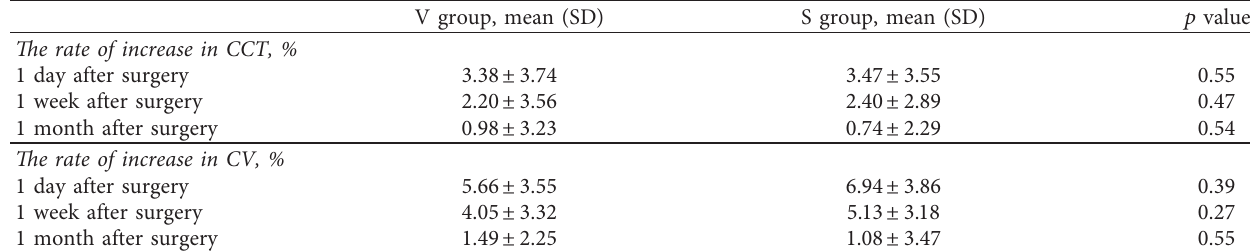
Table 2: The rate of increase in CCT and central 10.0mm